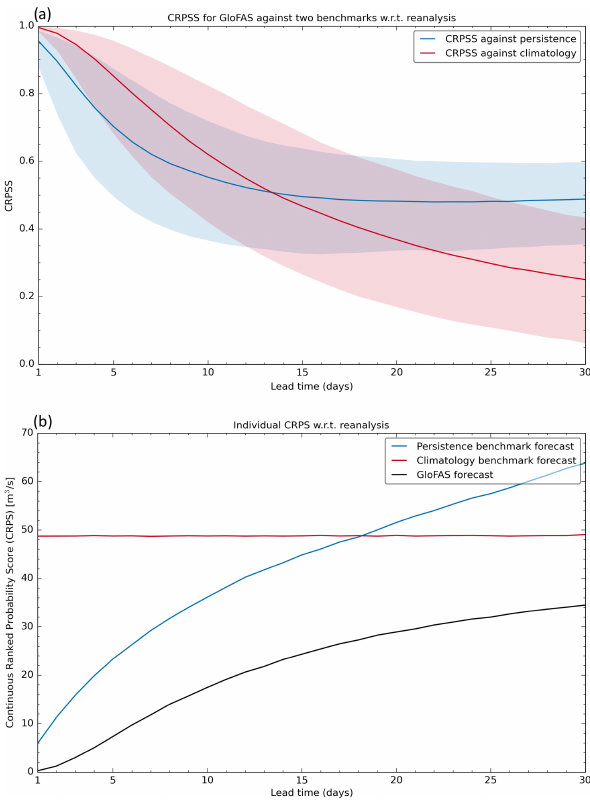
Figure 5. Skill of GloFAS 2.1/2.2 with global median continuous ranked probability skill score (CRPSS) for reforecasts against per- sistence (red line) and climatology (blue line) benchmarks from 1 to 30d lead times with respect to GloFAS-ERA5 river discharge re- analysis at 5997 diagnostic river points (a) . The interquartile range of CRPSS values at each lead time are shown by semi-transparent bands. Corresponding individual CRPS components used in Eq. (1) for GloFAS forecasts (black line), persistence benchmark (blue line) and climatology (red line) shown as a median across the diagnostic river points (b)